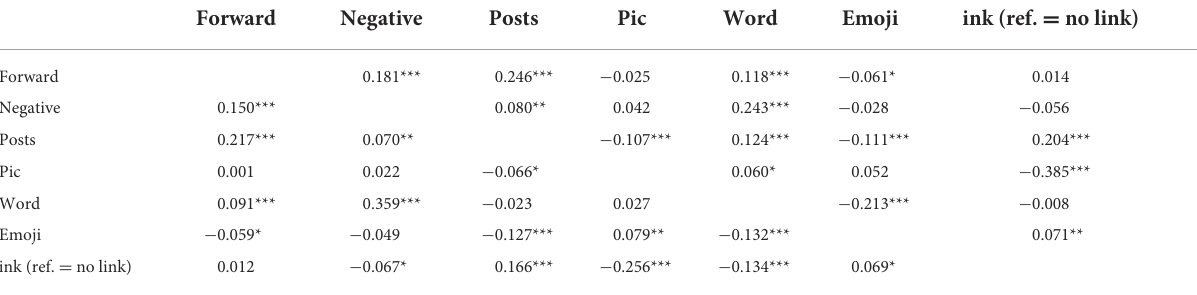
TABLE 11 Bivariate correlation analysis of negative sentiment regression model.